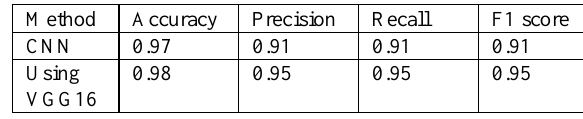
Table 2. Comparison of performance metrics for our